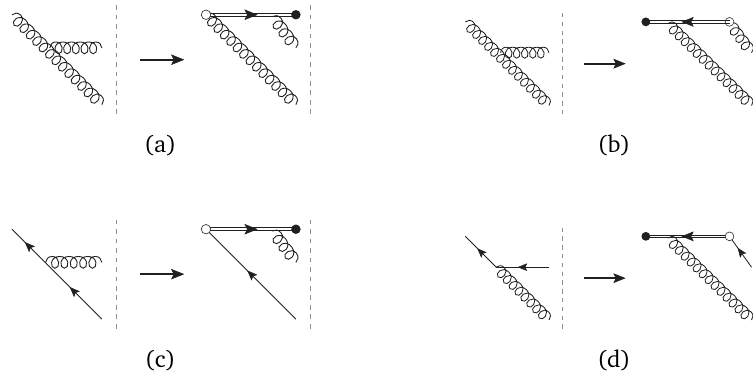
Figure 4: Rules for obtaining the Wilson line graphs needed in Feynman gauge from graphs without Wilson lines. In each of the four panels, the top left parton is an active one ( a or a ). These rules apply to both real and virtual graphs, and corresponding 1 2 rules hold on the right of the final state cut. Note that the three-gluon vertex in the upper panels gives rise to two different graphs.